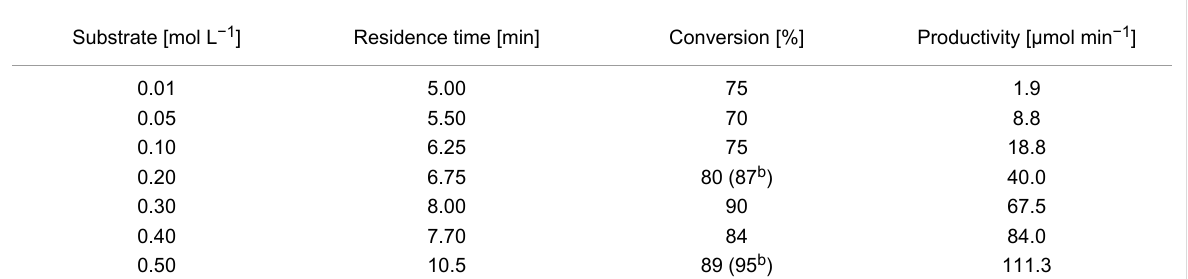
Table 2: Conversion vs substrate concentration.